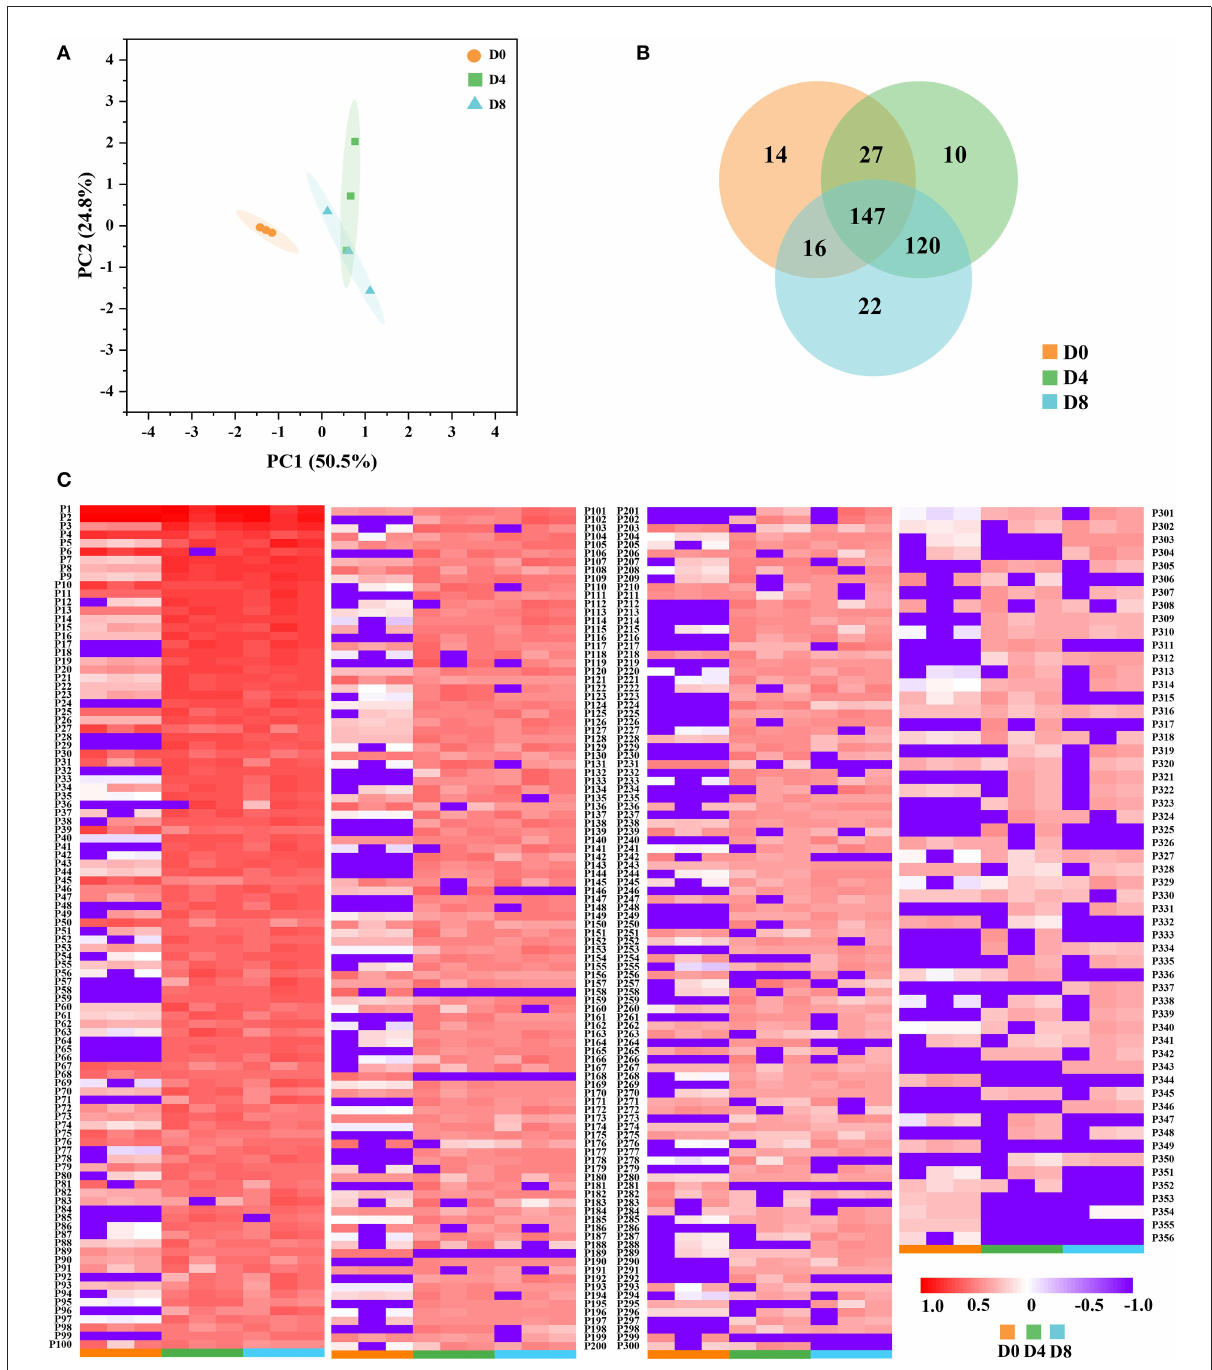
FIGURE1 Identification of angiotensin I converting enzyme (ACE) inhibitory peptides from Chouguiyu at different fermentation times. (A) Principal component analysis (PCA), (B) Venn, and (C) heatmap analysis of ACE inhibitory peptides in the D0, D4, and D8 fermentation groups.